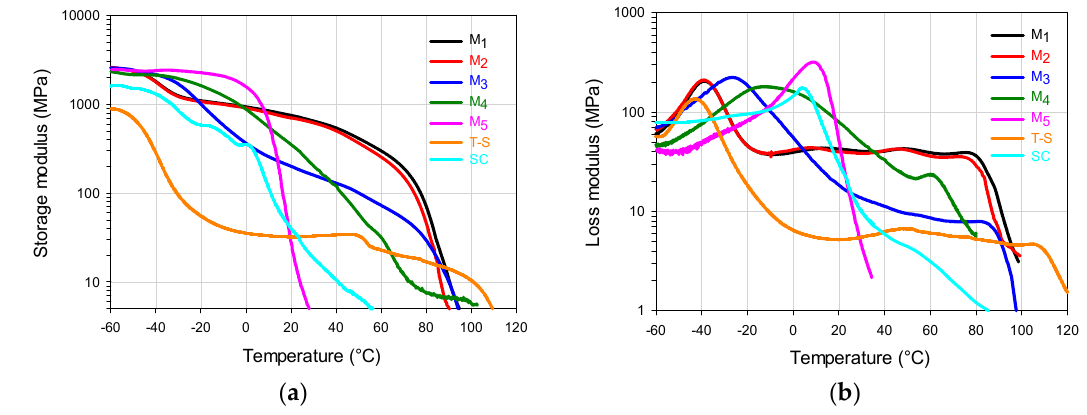
Figure 5. ( a ) Storage modulus; and ( b ) loss modulus as a function of temperature for: FCCs (M 1 –M 5 ), T-S and SC materials (frequency: 1 Hz). For codes, see Figures 1 and 2.